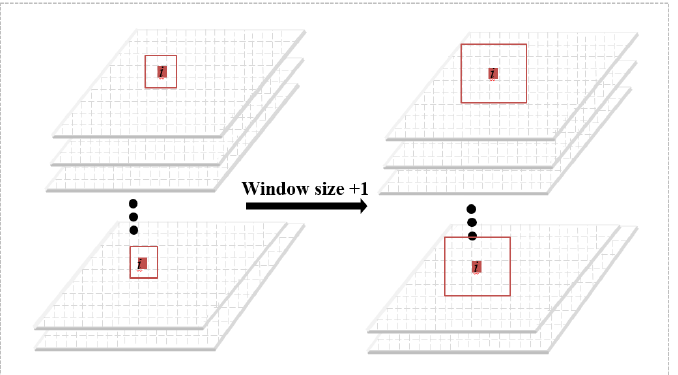
Figure 4. Diagram of the spatial window.